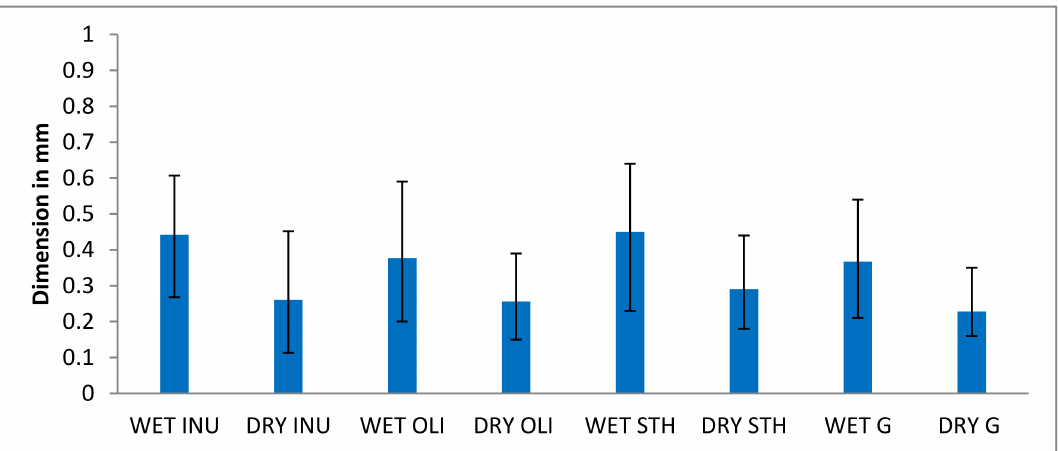
Figure 3. The dimensions of the wet and dry microcapsules in mm. Each bar presents the mean of three replicates. OLI— Microcapsules with oligofructose, STH—Microcapsules with starch, g—Microcapsules with glucose, INU—Microcapsules with inulin, the size is represented by the diameter of the